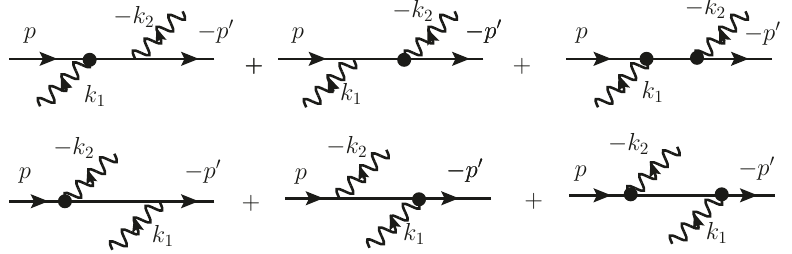
Figure 2 . Extra diagrammatic contributions to the spinor case. The bullets represent the coupling with σ µν in the second order formalism, see figure 1 of I. We use p, k outgoing